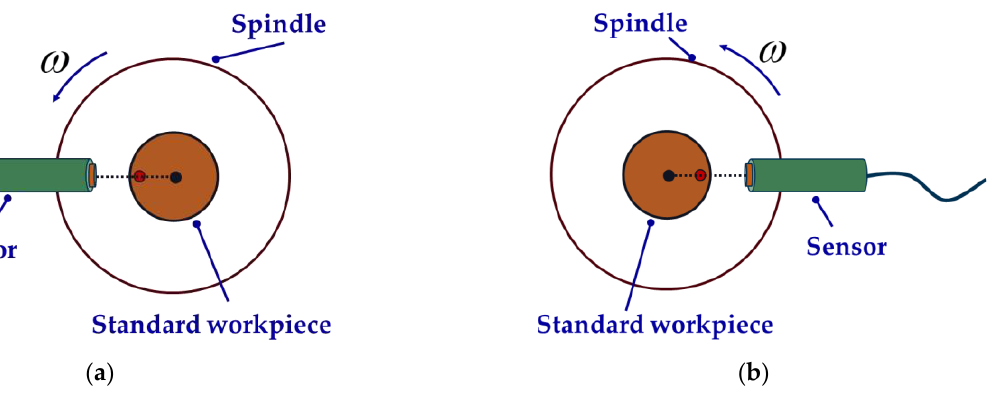
Figure 5. Schematic diagram of Donaldson reversal method measurement: ( a ) before reversal, ( b ) after reversal.